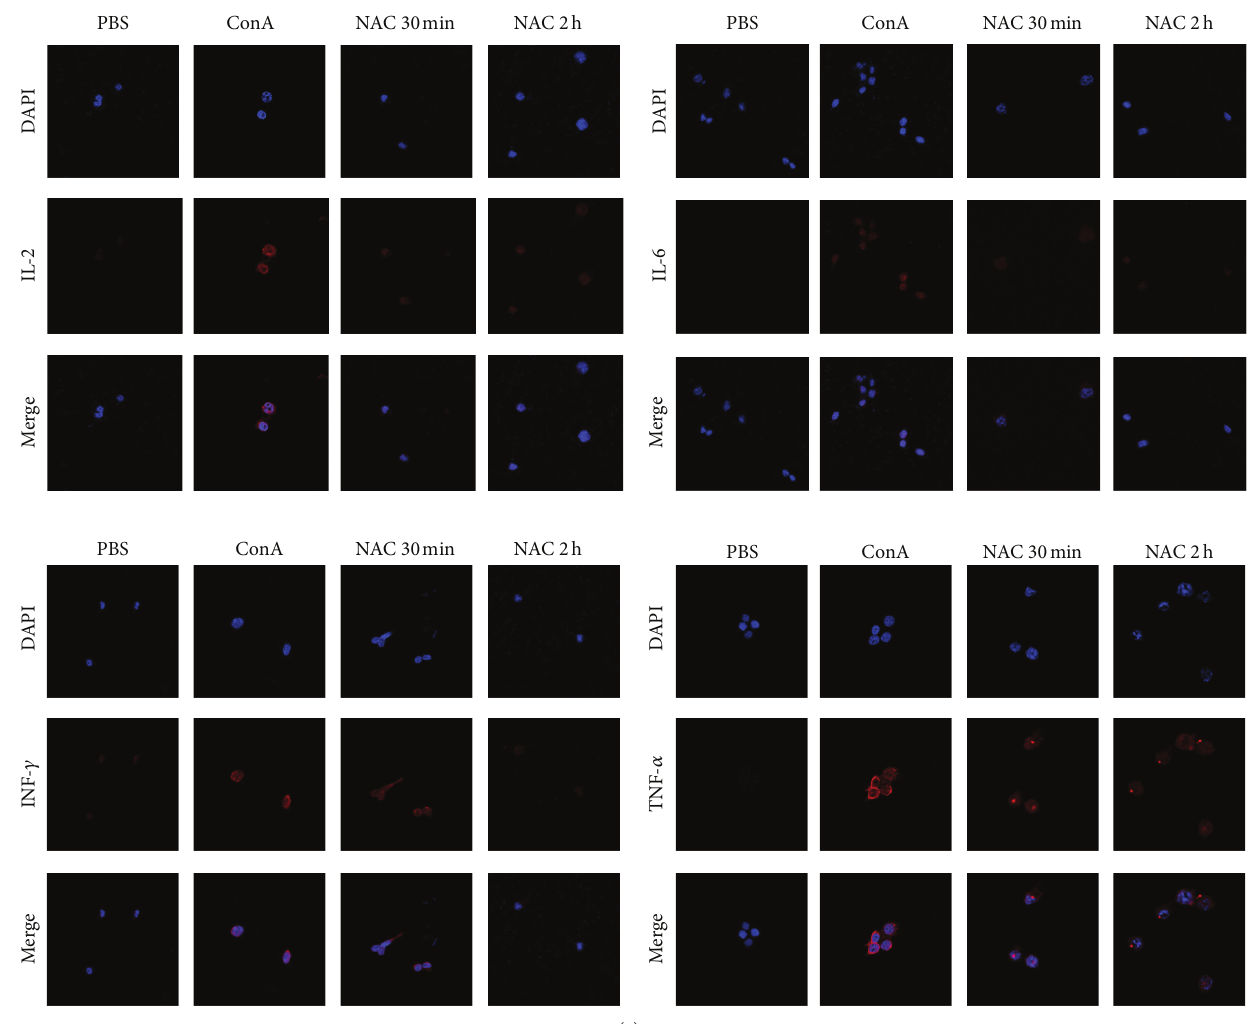
Figure 2: NAC inhibits cytokines release in ConA-induced autoimmune hepatitis. (a) Serum levels of IL-2, IFN- 𝛾 , and TNF- 𝛼 were measured by ELISA at 6h, 12h, and 24 h after ConA injection in mice. Data are expressed as mean ± SD ( 𝑛 = 6 ; ∗ 𝑃 < 0.05 for ConA versus NAC 30 min (post-NAC-treated, 30 min after injection with ConA); # 𝑃 < 0.05 for NAC 30 min (post-NAC-treated, 30 min after injection with ConA) versus NAC 2h (NAC-pretreated, 2h before injection with ConA)). (b) The expressions of IL-2, IL-6, IFN- 𝛾 , and TNF- 𝛼 on mRNA levels were detected by real-time PCR. Data are expressed as mean ± SD ( 𝑛 = 6 ; ∗ 𝑃 < 0.05 for ConA versus NAC 30 min; # 𝑃 < 0.05 for NAC 30 min versus NAC 2 h). (c) The expressions of IL-2, IL-6, IL-1 𝛽 , IFN- 𝛾 , and TNF- 𝛼 on protein levels were detected with western blot. (d) The results of western blot were analyzed with Quantity One. Data are expressed as mean ± SD ( 𝑛 = 6 ; ∗ 𝑃 < 0.05 for ConA versus NAC 30 min; # 𝑃 < 0.05 for NAC 30 min versus NAC 2 h). (e) The differently expressions of IL-2, IL-6, IFN- 𝛾 , and TNF- 𝛼 in macrophages’ localization were evaluated by immunofluorescence (magnification is